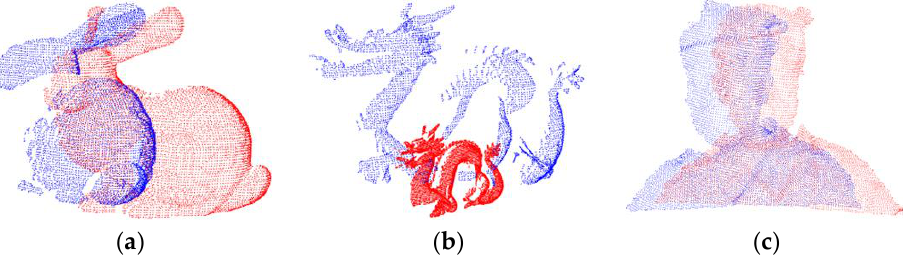
Figure 5. Three groups of PCD consisting of bunny rabbit, dragon and scanned face. ( a ) Bunny rabbit bun045 and bun090. ( b ) Dragon000 and dragon048 with scale factor 2. ( c ) Scanned face face000 and face045. Table 3. The RMSE of ICP, coarse-to-ICP, TrICP and coarse-to-TrICP registration results.